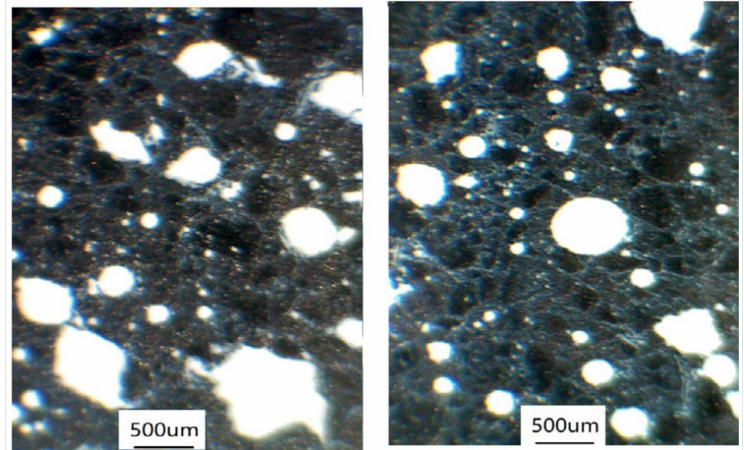
Figure 22. Bubble of comparison samples.